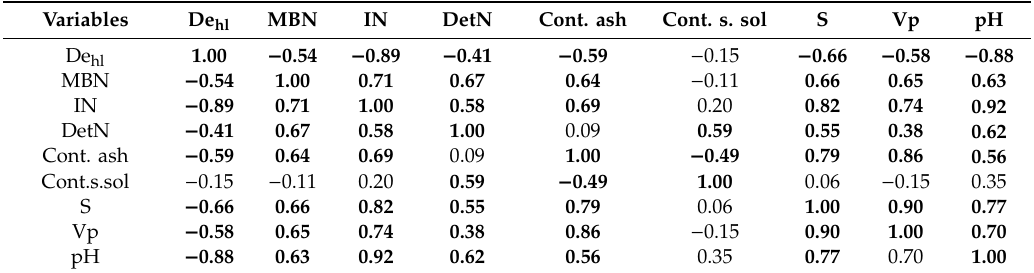
Table 3. Spearman’s rank correlation coe ffi cient between particular characteristics of the analyzed activated carbons.